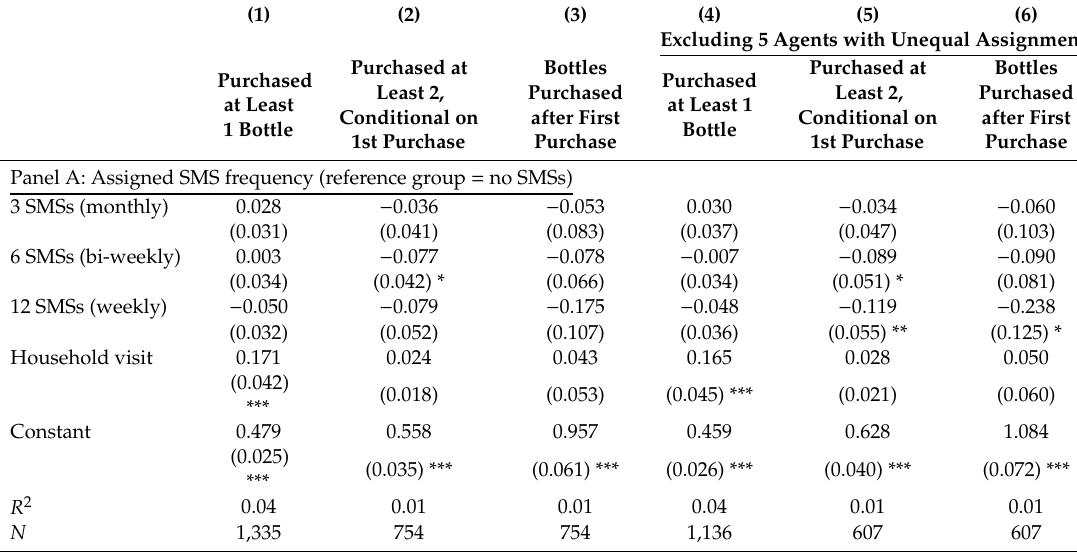
Table 7. Di ff erential impact of visits on di ff erent purchase indicators